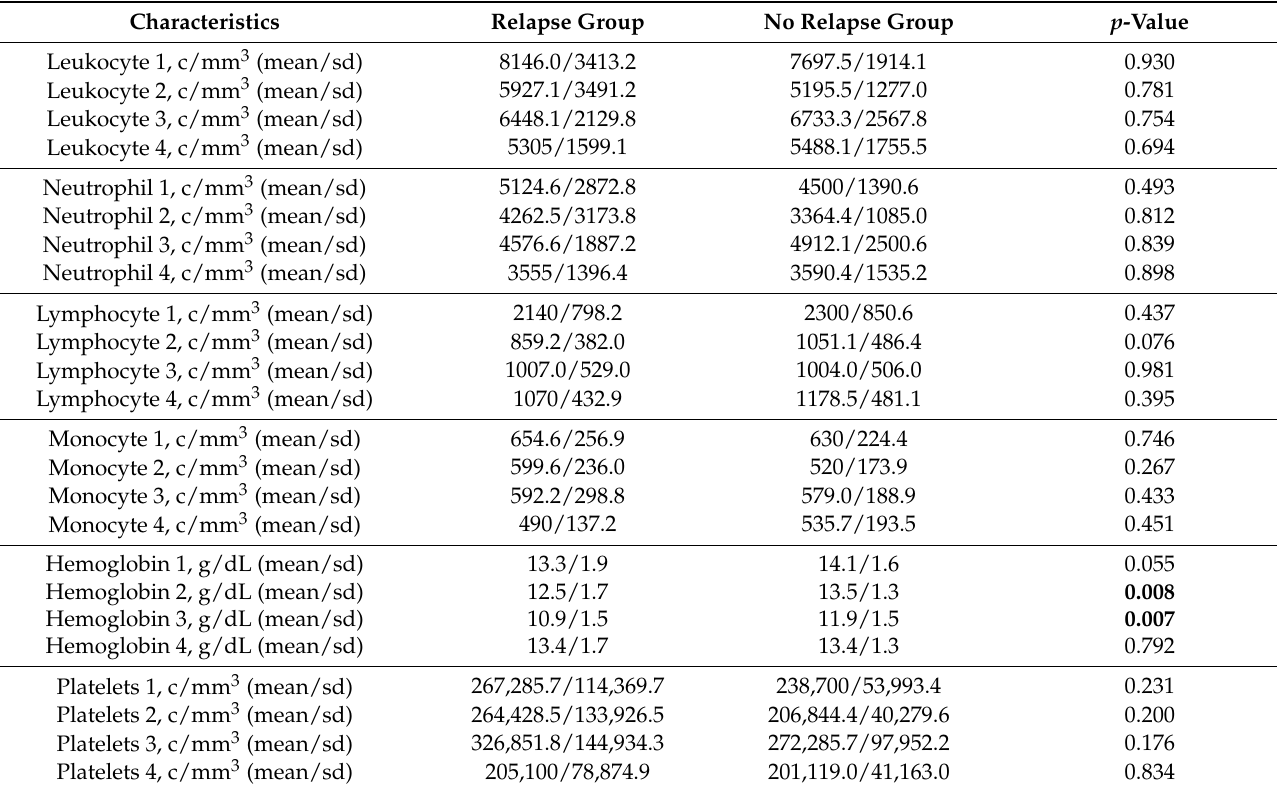
Table 2. Univariate analysis of hematologic parameters.